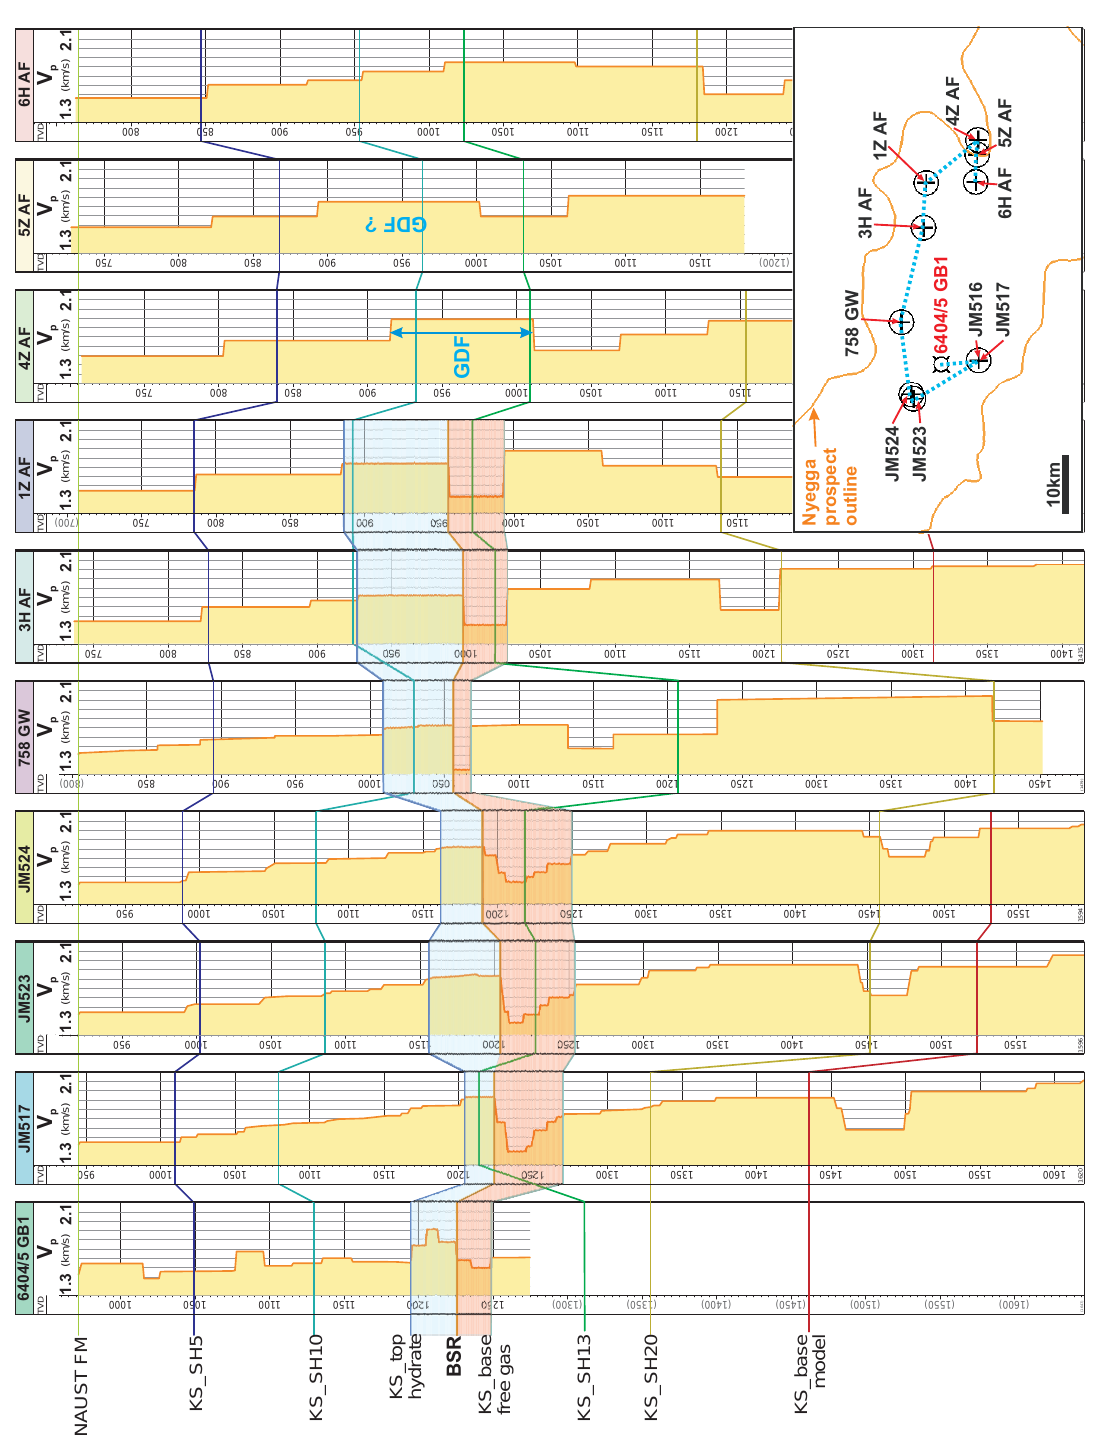
Figure 8. Summary of ocean-bottom seismic (OBS) data of Bünz et al. [56], Westbrook et al. [58] and Faverola et al. [63] compared to the 6404/5 GB1 measured P-wave velocity. The bottom simulating reflection (BSR) well top is defined on the basis of the onset of the low velocity anomaly on the OBS data, and is notably absent at stations 4Z, 5Z and 6H. The remaining tops are defined by the intersection of the interpreted horizons with the “well path” of the OBS stations. Note that GDF = glacigenic debris